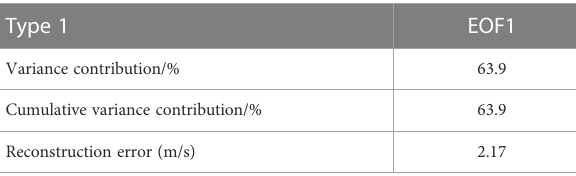
TABLE 2 First fi ve orders contribution rates and errors for Type 1.